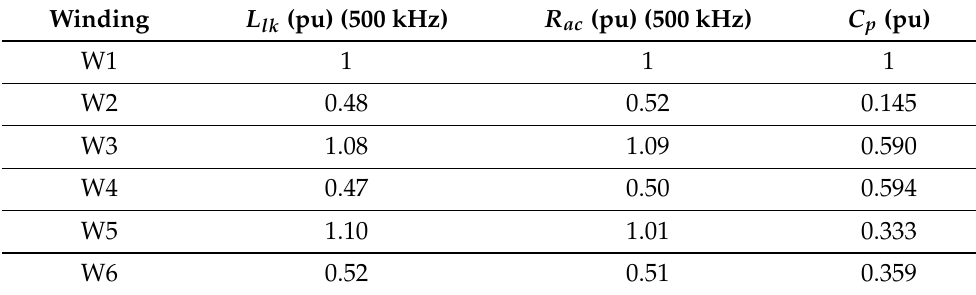
Table 2. Comparison of leakage inductance, AC resistance, and parasitic capacitance of winding arrangements W1–W6 (partially interleaved and non-interleaved structures), normalized according to